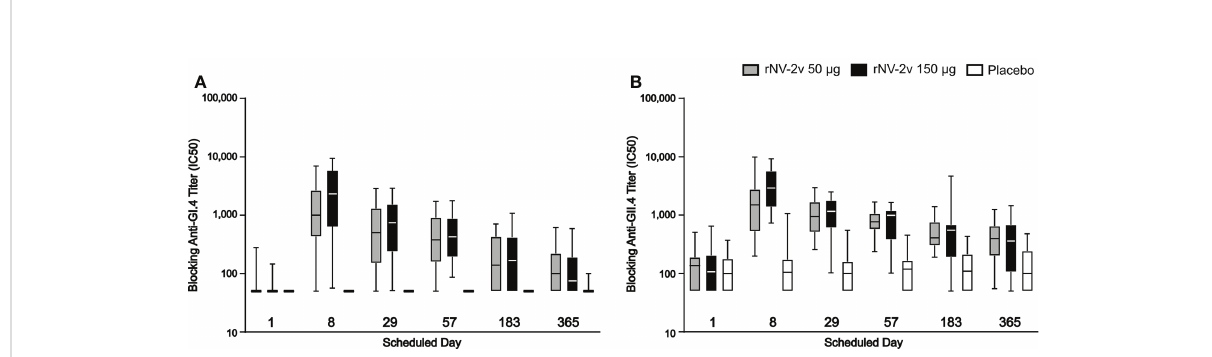
FIGURE 6 Serum antibodies blocking GI.4 and GII.4 VLP binding to histo-blood group antigen. Blocking of binding of GI.4 VLP (A) and GII.4 VLP (B) to Pig Gastric Mucin by antibodies elicited by rNV-2v 50µg (gray), 150 µg (black) and placebo (white) expressed as half maximal inhibitory concentration (IC50) which represents the effective concentration (titer) of the serum where the blocking of the VLP binding is reduced by half of the maximal VLP blocking. The horizontal line represents the median, the bottom and top of the box represent 25 th and 75 th percentiles of the values, respectively, and the upper and lower error bar represent 5 th and 95 th percentile of the values, respectively. PGM, Pig Gastric Mucin, VLP, virus-like